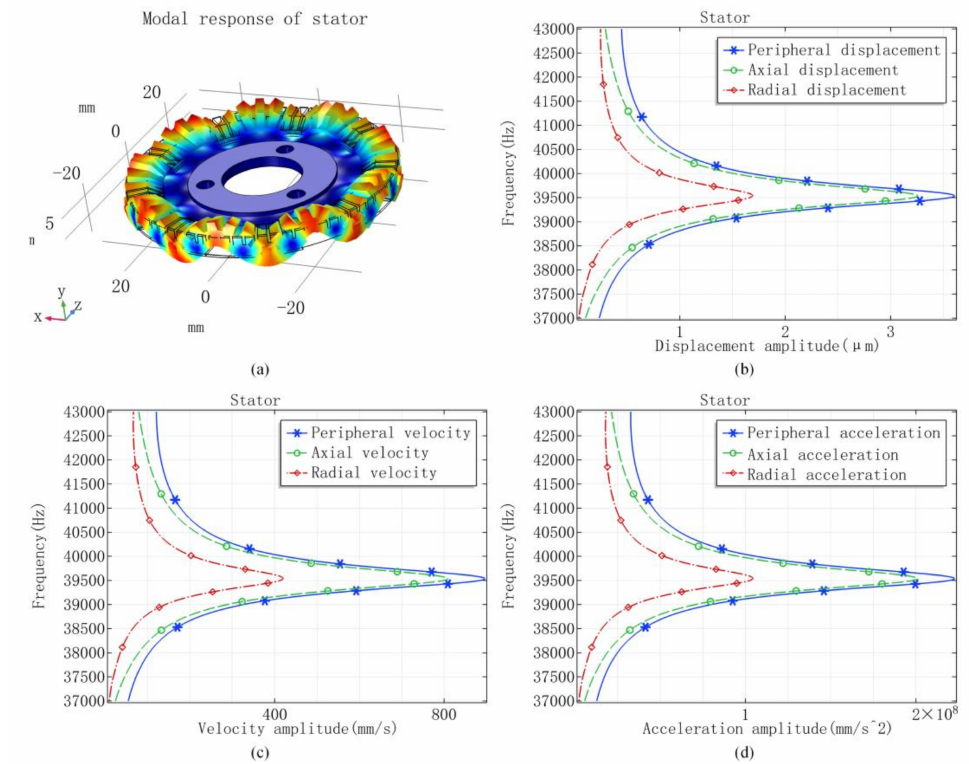
Figure 2. Amplitude response of the stator in the peripheral, axial and radial directions. ( a ) Modal response nephogram of stator. ( b ) Displacement amplitude versus sweeping drive frequency. ( c ) Velocity amplitude versus sweeping drive frequency. ( d ) Acceleration amplitude versus sweeping drive